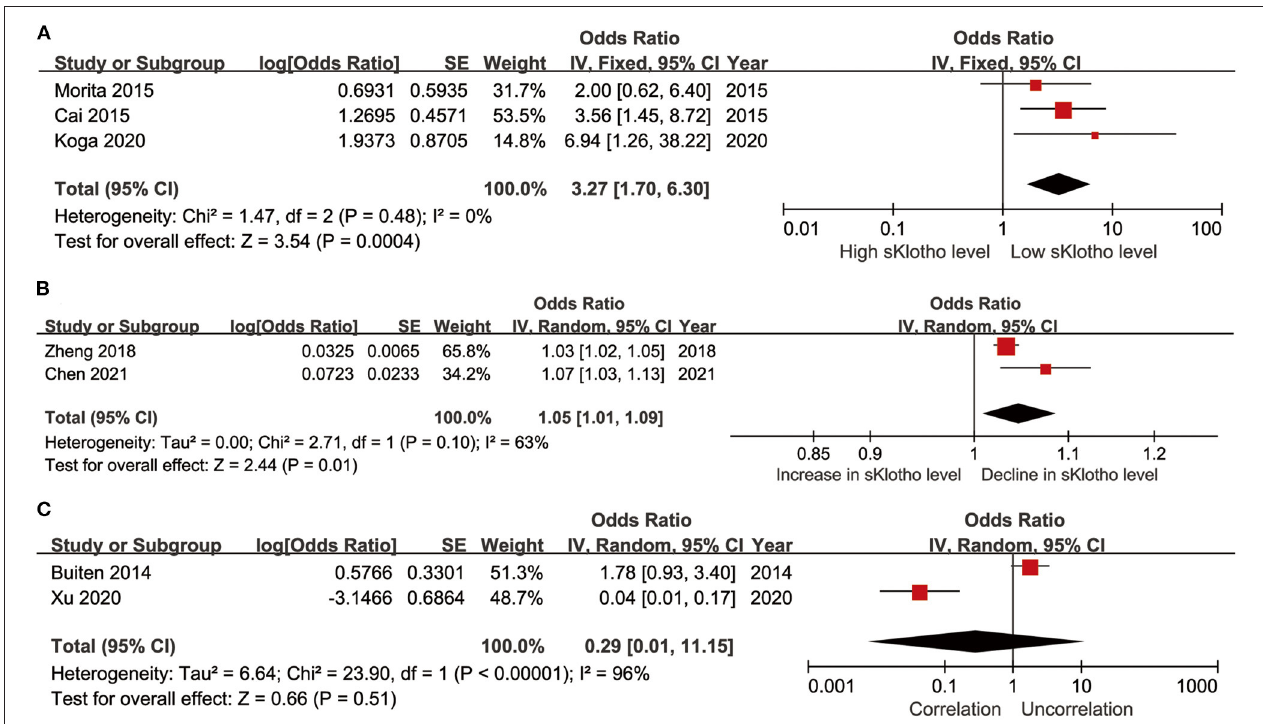
FIGURE 5 | Forest plots of the summary OR for the association between sKlotho level and VC; (A) sKlotho as a categorical variable; (B) sKlotho as a continuous variable; (C) Result of multivariate linear regression analysis.